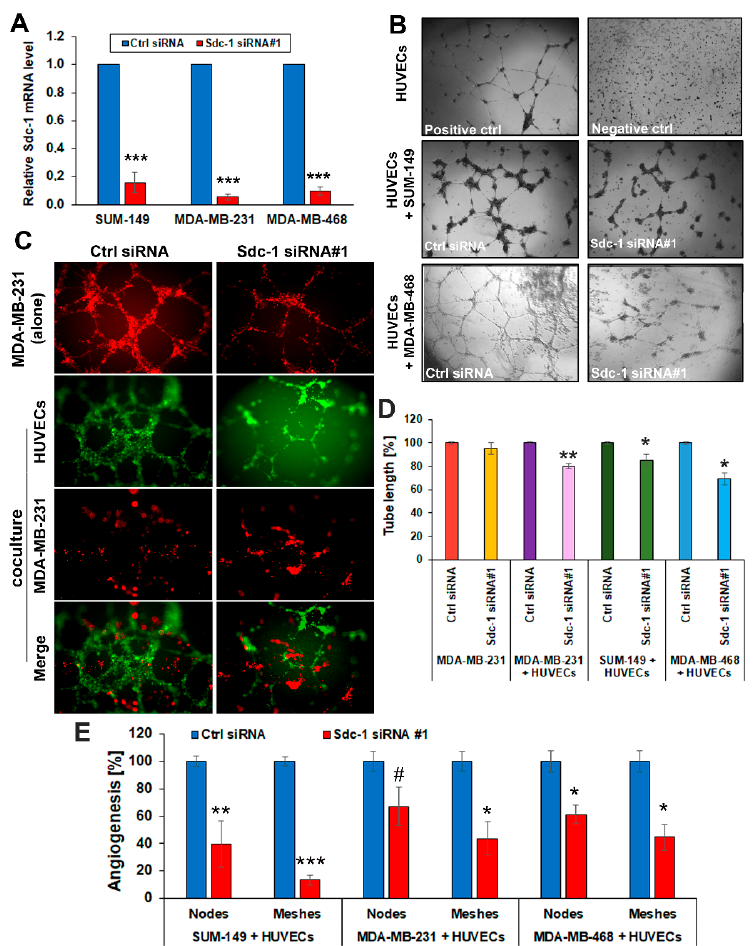
Figure 1. Sdc-1 depletion in TNBC cells restrains angiogenesis network formation of HUVECs. ( A ) Sdc-1 knockdown was confirmed by qPCR in the triple-negative cell lines SUM-149, MDA-MB-231, and MDA-MB-468. ( B – E ) 3D co-culture models of HUVECs and the control siRNA and Sdc-1 siRNA transfected SUM-149, MDA-MB-468, and MDA-MB-231 cells. ( B ) Phase-contrast images for HUVECs were either grown in 3D alone (as negative or positive controls) or co-cultured with control and Sdc-1-suppressed SUM-149 and MDA-MB-468 cells for 24 h. ( C ) Confocal immunofluorescence microscopy shows tubule formation by only HUVECs (green fluorescent staining) and not by MDA- MB-231 cells (red fluorescent staining) in a co-culture 3D system. Notably, MDA-MB-231 cells formed tubules when cultured alone in 3D on Matrigel. ( D ) Quantitative analysis of HUVEC tubu- formed by HUVECs as analyzed by angiogenesis analyzer software. Panels ( A , D , E ): Data represent the mean ± SEM, n = 3. *** p < 0.001, ** p < 0.01, * p < 0.05, and # p = 0.09 as determined by Student’s t